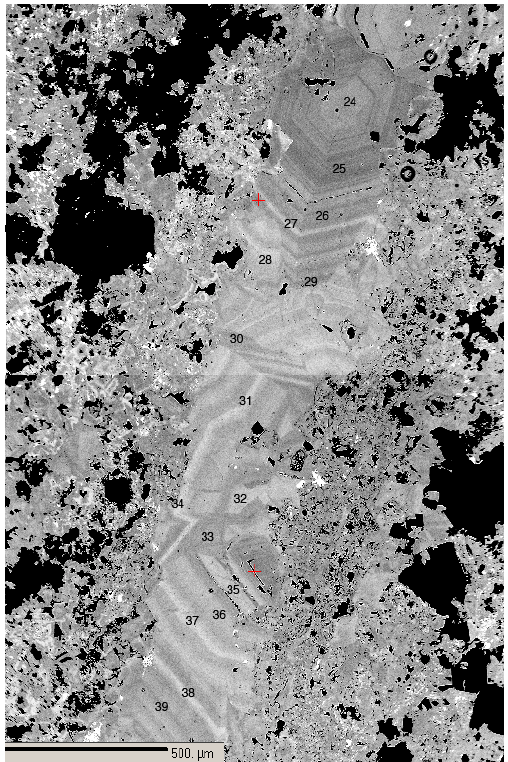
Figure 5. Backscattered scanning electron micrograph of zoned willemite, sample TM06-15. Numbers represent analyses, reported in Table S1.